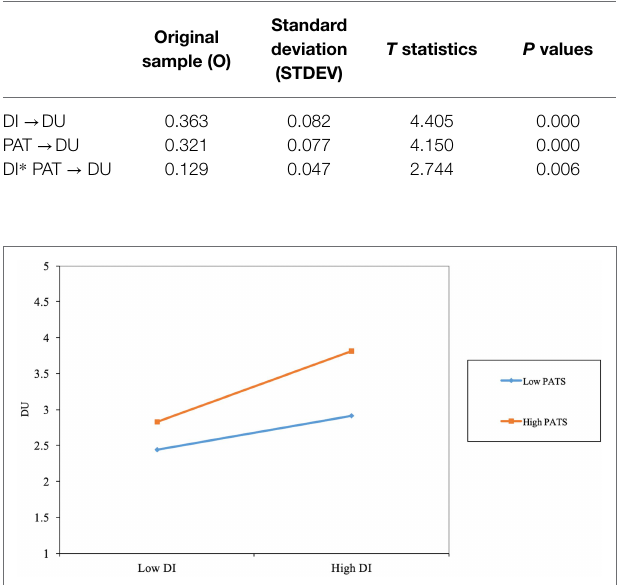
TABLE 8 | Moderating effects among the proposed relationships.